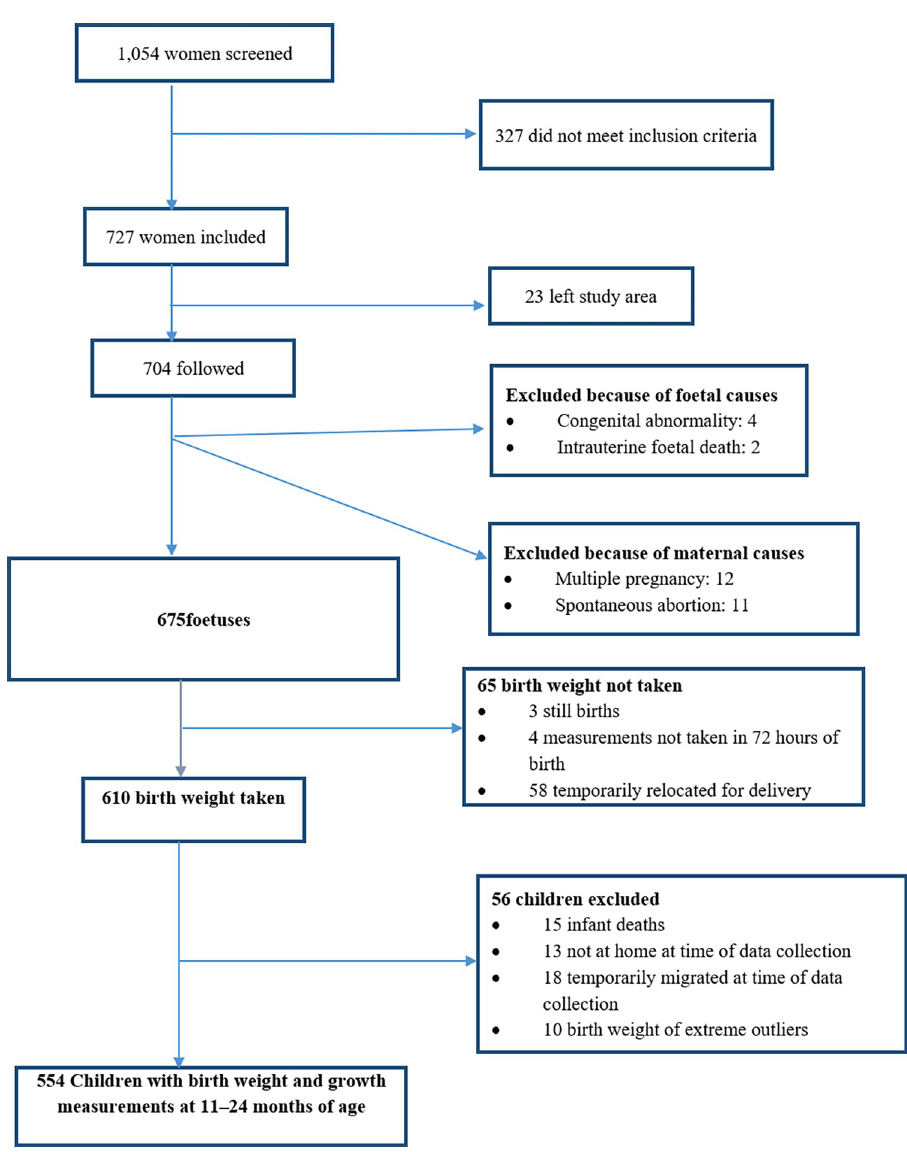
Fig 2. Flow chart of study participants from fetal to postnatal period at age of 11–24 months, Adami Tullu district